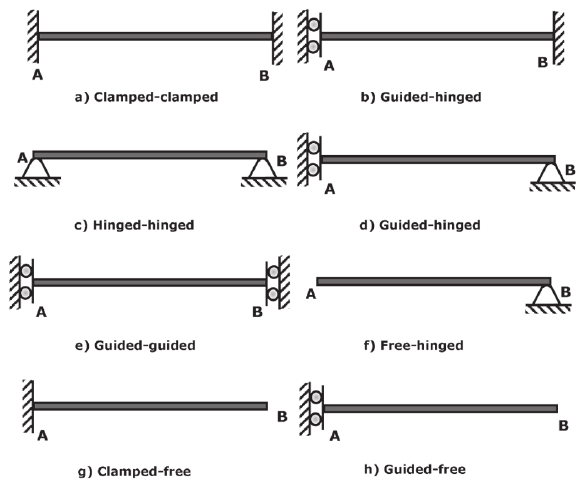
Fig. 2. Examples of the beams resulting from the extreme conditions of spring